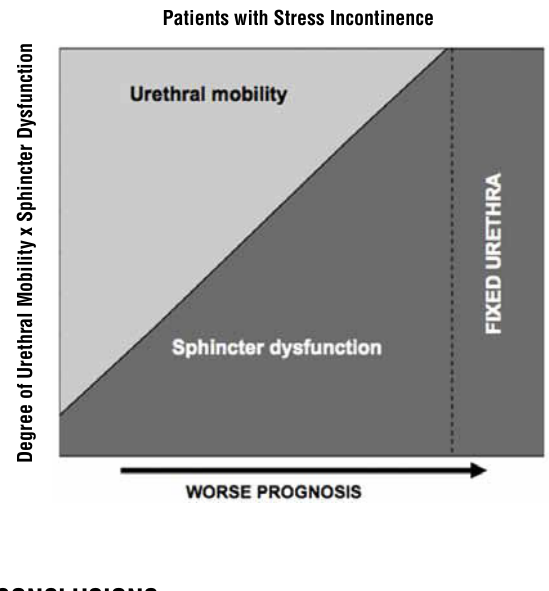
Figure 1 - Prognostic interaction between urethral mobility and sphincter dysfunction in women with SUI after sling procedure. Note that some degree of sphincter dysfunction is required for incontinence to